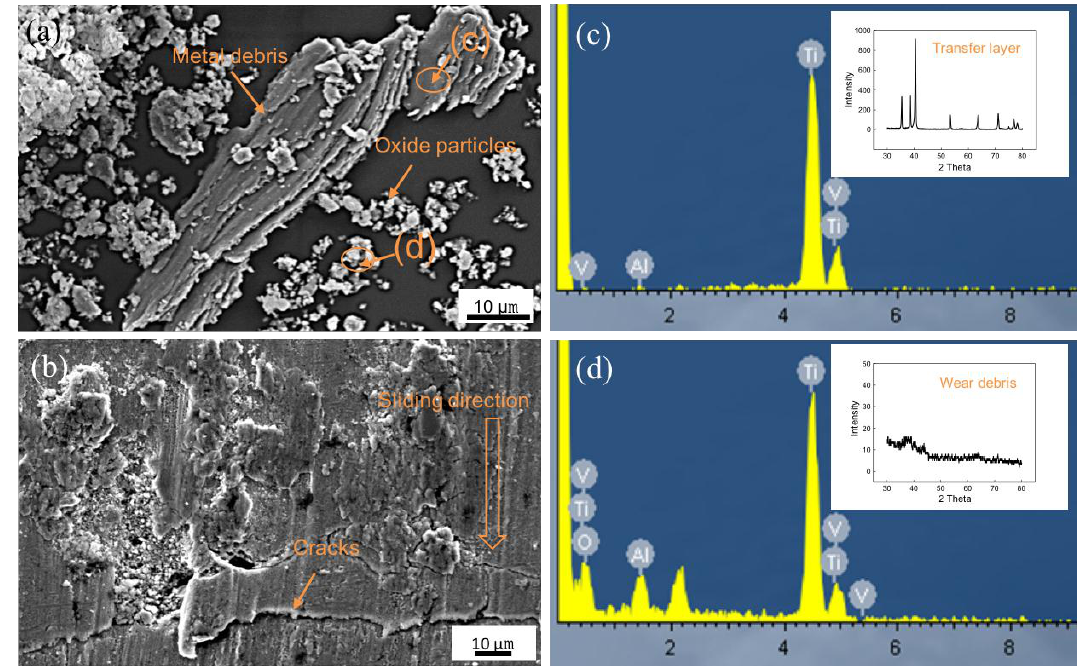
Figure 11. ( a ) SEM micrograph of the transfer layers generated by sliding on the 0.5 mm EBM-built sample; ( b ) SEM micrograph of the wear track on the 0.5 mm EBM-built sample after wear test; ( c ) EDX spectrum and inserted XRD patterns of the transfer layers and ( d ) EDX spectrum and inserted